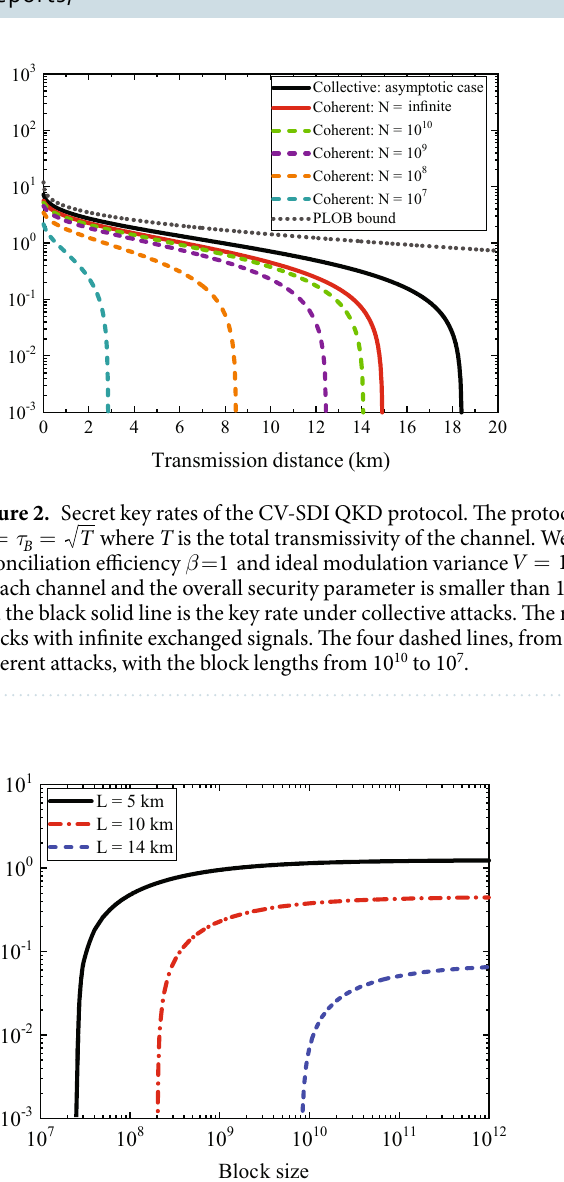
collective attacks, and the longest transmission distance is over 18 km, which is a little shorter than that of the two-mode individual attacks case (where the correlation parameter g = 0) 34 . The other five curves, from top to bottom, describe the key rates under coherent attacks. The red solid curve is obtained for N → ∞ , and the other dashed lines describe the rate for N = 10 10 to N = 10 7 with finite exchanged signals. In Fig. 3, we also plot the secret key rate under coherent attacks as a function of block size for different distances. The distances are 5 km, 10 km and 14 km, respectively. We point out that when the block size reduces, the secret key rate decreases, and it is not achievable if the block size is below 10 7 .